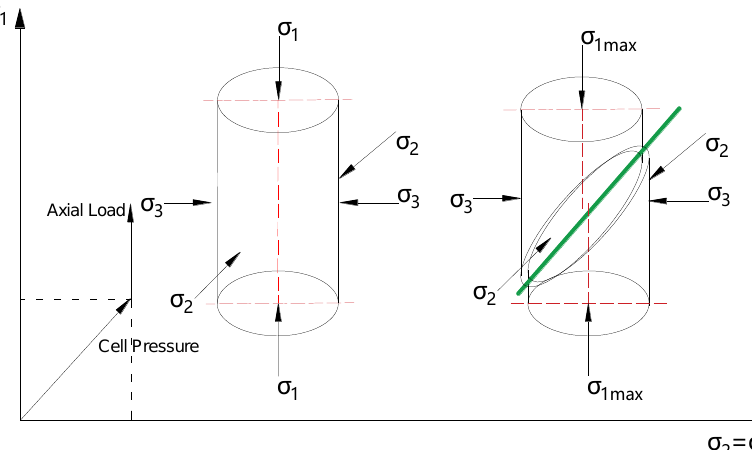
Figure 7. Evolution of stress state of SMS specimen in triaxial compression test.